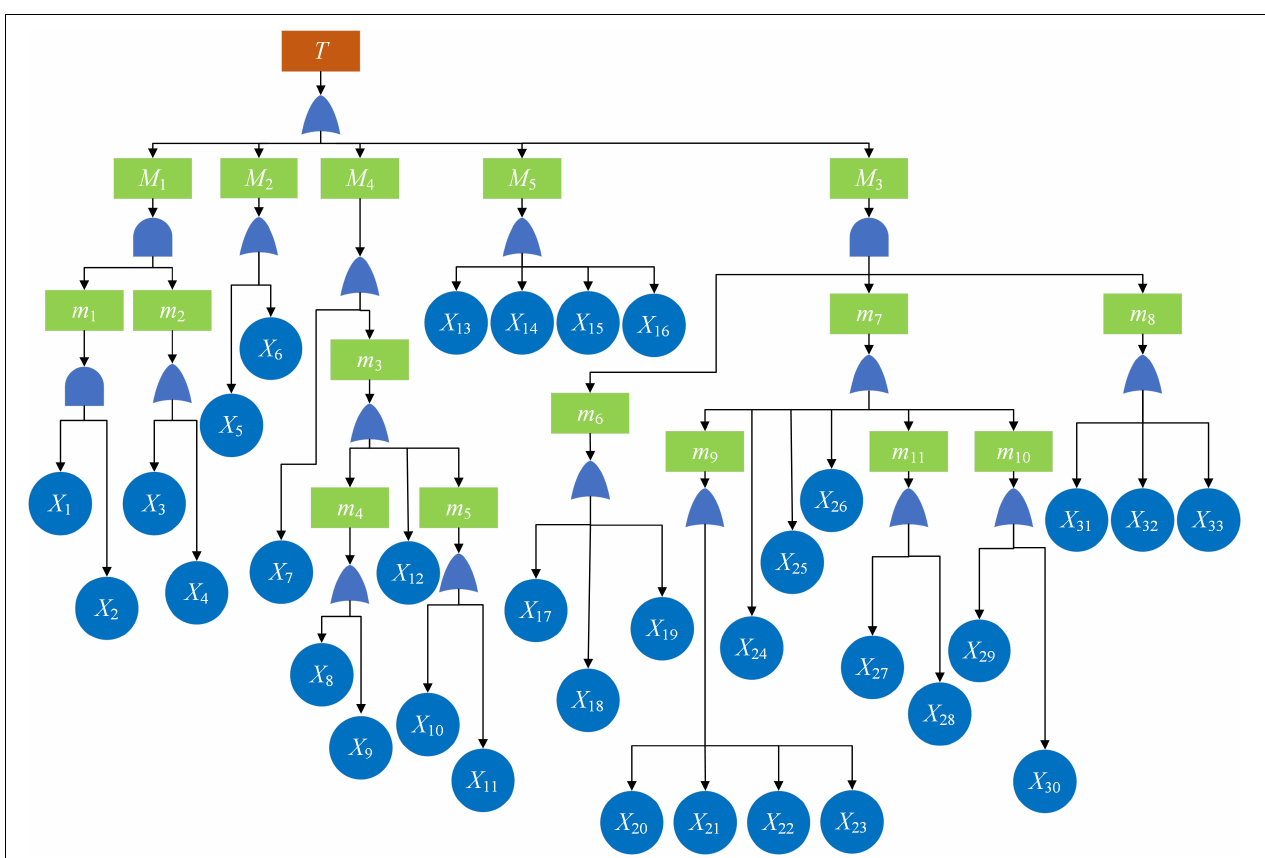
FIGURE 3 | Subway construction accident causation mechanism